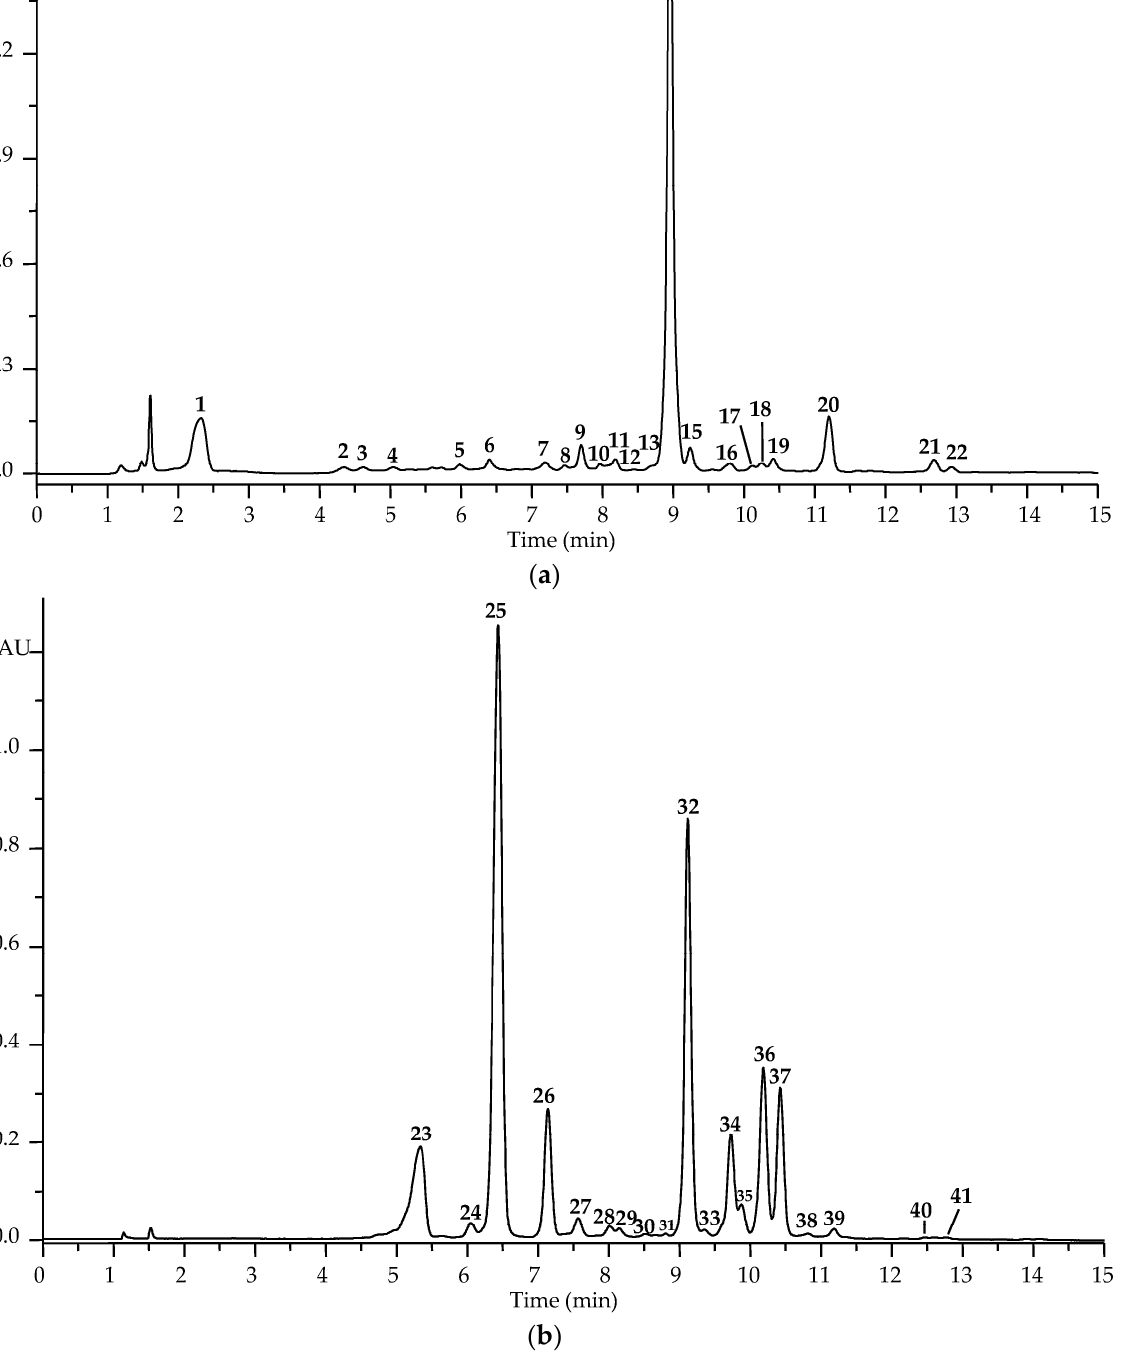
Figure 1. High-performance liquid chromatography with photodiode array detection chromatogram of SPE-1 (( a ); 254 nm) and SPE-2 (( b ); 330 nm) fractions of K. centauroides leaf extract. Compounds are numbered as listed in Table